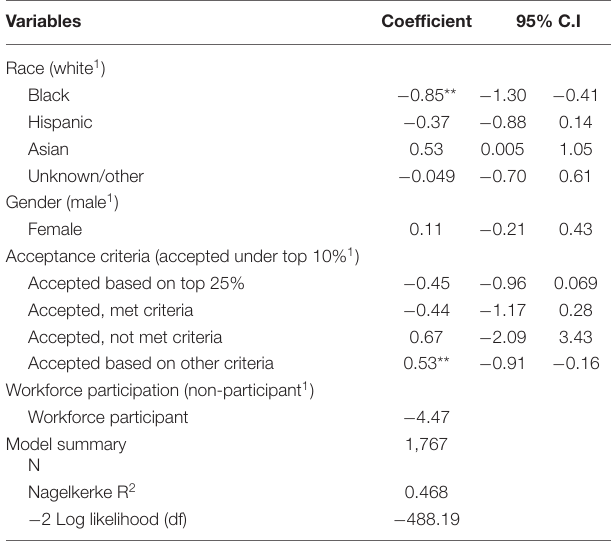
TABLE 4 | Logistic regression results–effect of workforce participation on graduation of H-LSAMP